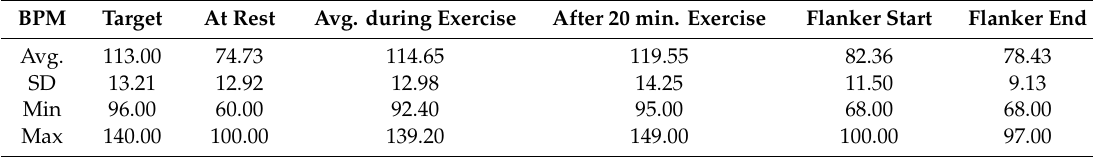
Table 1. Average heart rate values (beats per minute (BPM)) at rest, during the intervention (minutes 2 to 20), after 20 min of exercising, at the start and end of the Flanker task, as well as the target heart